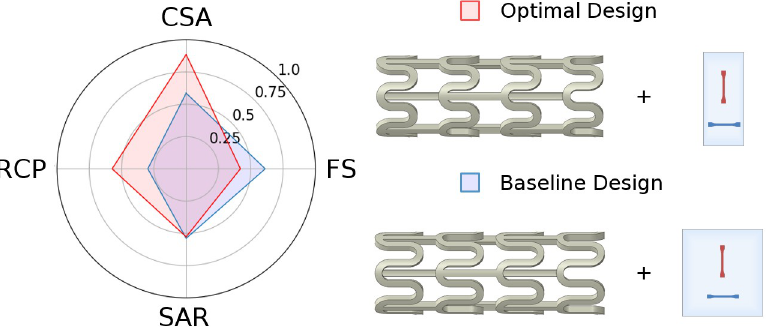
Fig 16. Visual comparison of normalised performance metrics and design parameters between the baseline design and the optimal design.